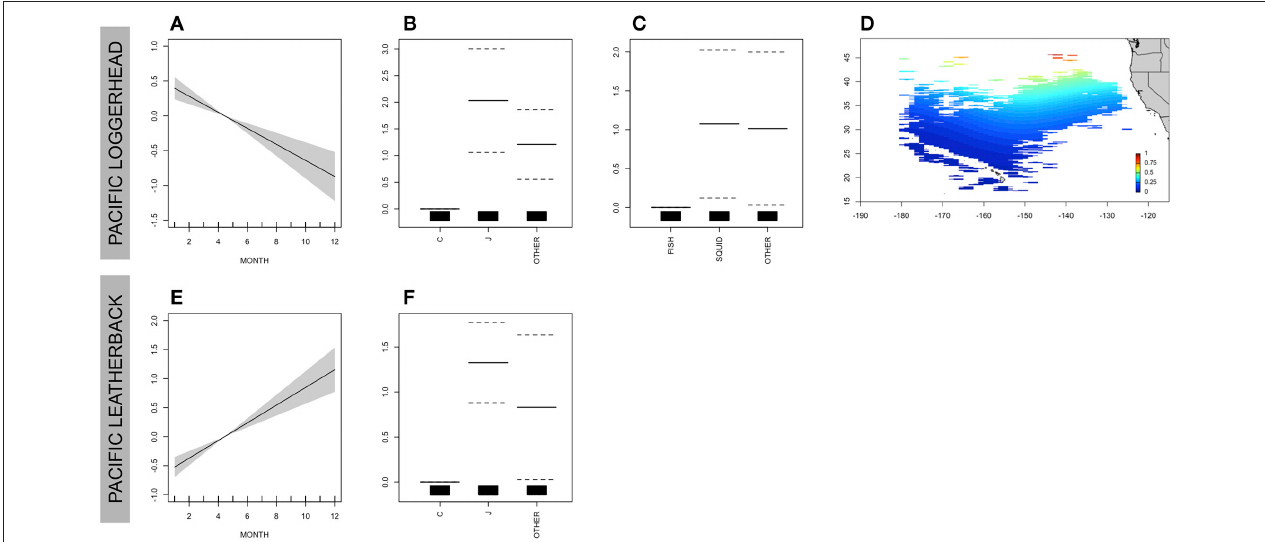
FIGURE 8 | Effect of gear characteristicsand location on the probability of catch of loggerheads (A–D) and leatherbacks (E,F) in the Pacific. The y -axis is in logit units and represents deviation from the logit mean. The smoothed probability of capture is scaled by its coefficient from the Generalized Additive Mixed Model (GAMM) model. The shaded area represents the upper and lower twice-standard-error curves. For factors, solid lines are the mean and the first factor is the reference group centered at zero, dashed lines represent upper and lower twice-standard errors. Positive (negative) values represent higher (lower) probability of catch from the mean capture probability. Vertical ticks on the x-axis indicate data distribution. For the Pacific, the probability of loggerhead turtle capture is a function of (A) Month, (B) Hook Type, (C) Bait Type, (D) Location (scaled between 0 and 1 catch probability). For the Pacific, the probability of leatherback turtle capture is a function of (E) Month, and (F) Hook